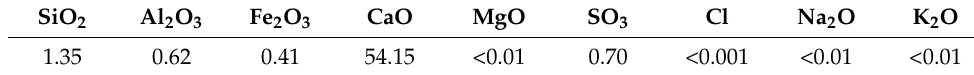
Table 2. Chemical composition of the limestone powder used in the tests [% by weight].